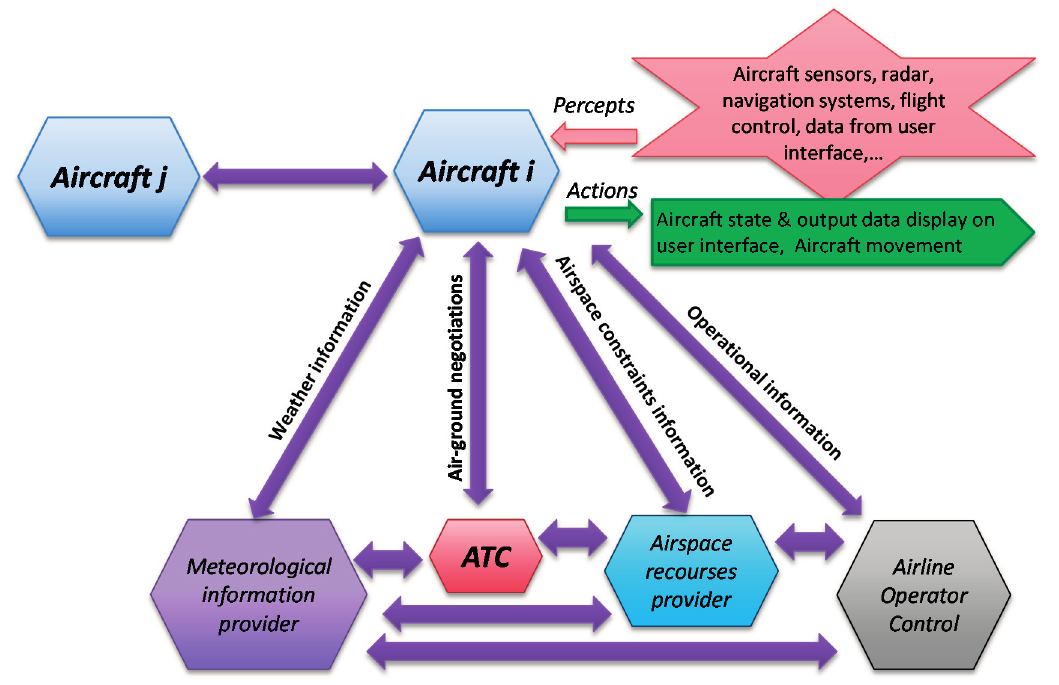
Figure 4. Simplified System